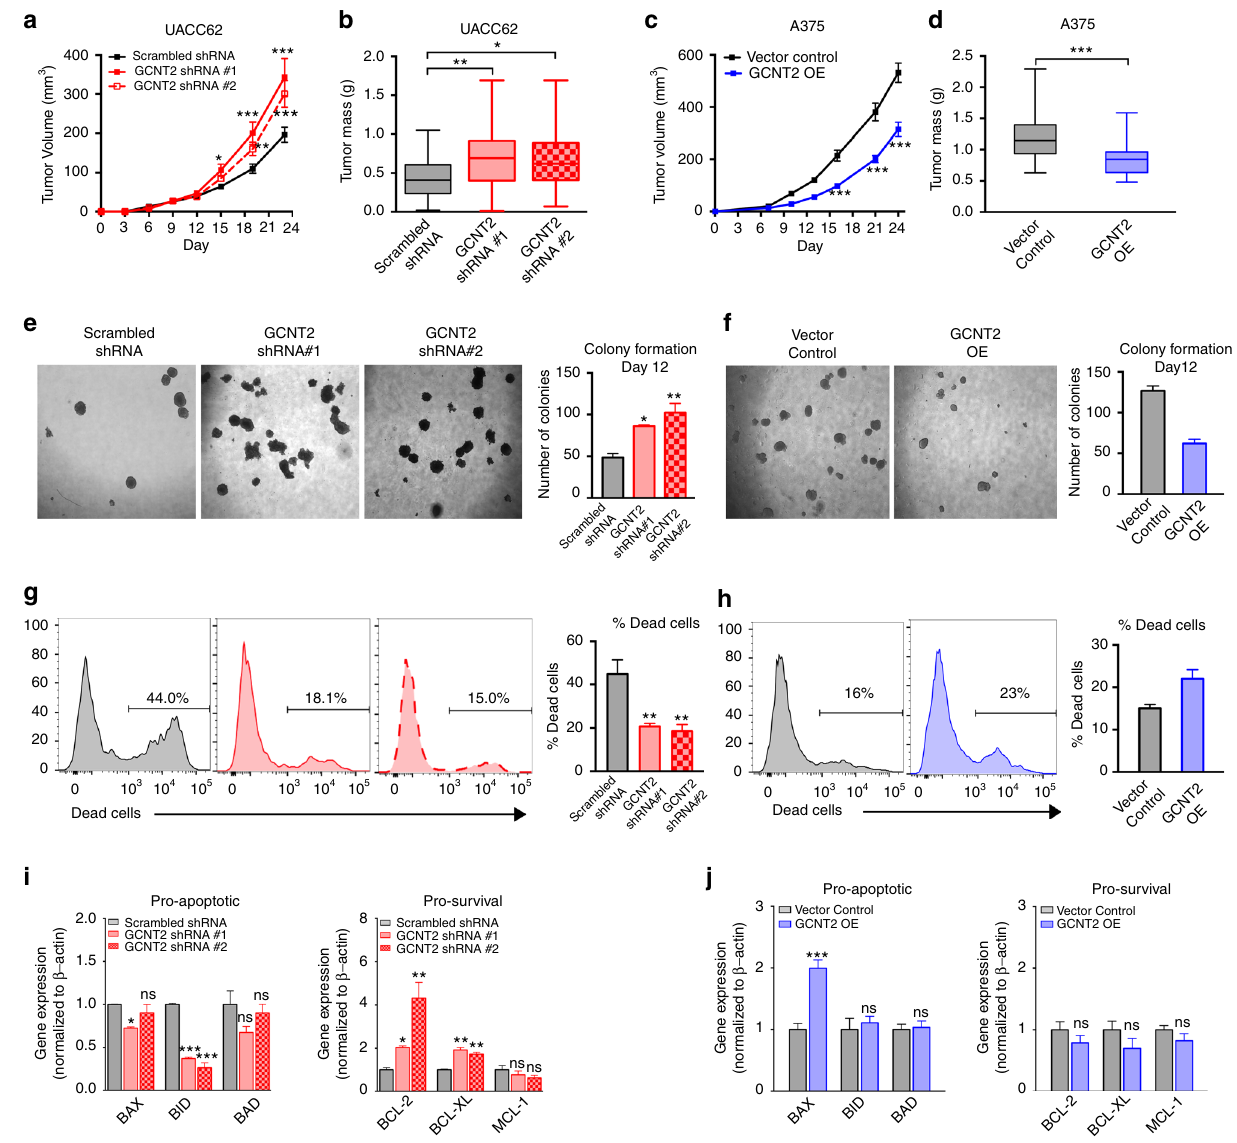
Fig. 4 Loss of GCNT2 enhances melanoma growth and survival. a , b Tumor growth kinetics ( a ) and mass ( b ) of UACC62 scrambled control and GCNT2 KD cell variants in NSG mice. c , d Tumor growth kinetics ( c ) and mass ( d ) of A375 vector control and GCNT2 OE cell variants in NSG mice. e , f Photographs (left) and quantitation (right) of UACC62 scrambled control and GCNT2 KD ( e ) and A375 vector control and GCNT2 OE ( f ) single cell colony formation in 1% methylcellulose. g , h Representative fl ow cytometry plots (left) and quantitation (right) of dead cells from UACC62 scrambled control and GCNT2 KD cell colonies ( g ) and A375 vector control and GCNT2 OE ( h ) cell colonies. i , j Apoptotic/survival family gene expression measured by qRT-PCR in UACC62 scrambled control and GCNT2 KD ( i ) cell colonies and A375 vector control and GCNT2 OE ( j ) cell colonies. Statistical analyses were done using one-way ANOVA with Dunnett ’ s multiple comparisons test, two-way ANOVA with Dunnett ’ s multiple comparisons test, or unpaired two-tailed Student ’ s t test. Results are representative of n = 20 tumors from n = 4 experiments and n = 6 methylcellulose wells from n = 2 experiments (mean ± SEM; ** p < 0.01; *** p < 0.001). See also Supplementary Fig.